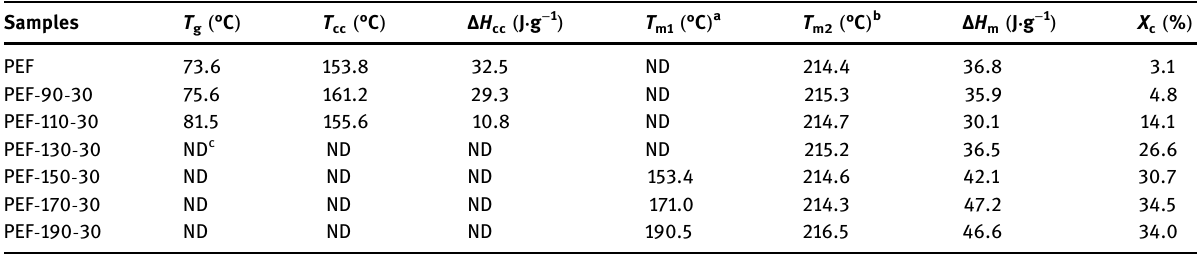
Table A1: Thermal properties of PEF - T - 30 Samples